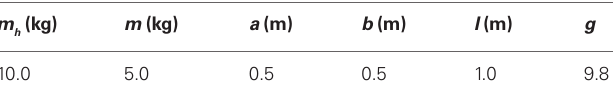
Table 1 | Model parameters.